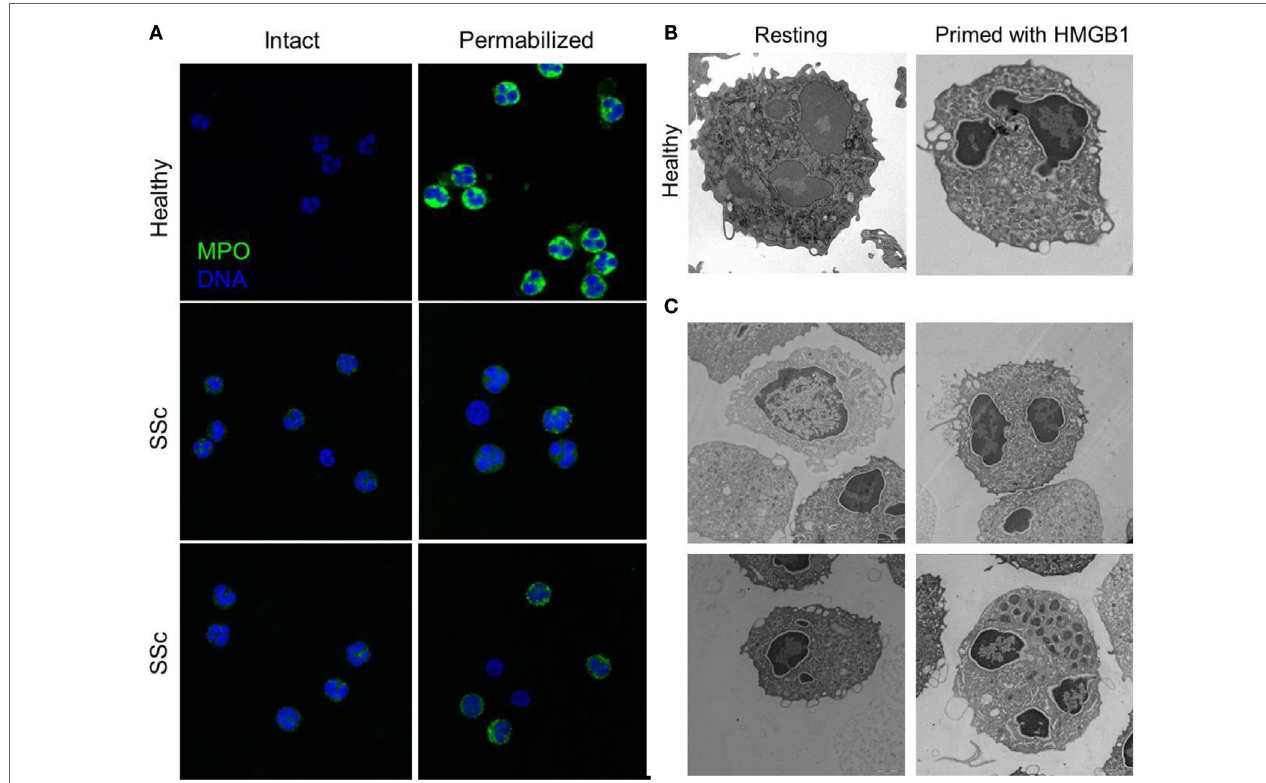
FiGURe 4 | Peripheral granules distribution characterized neutrophils of patients with SSc . (A) The expression of MPO (green) in the blood neutrophils of patients with SSc and of matched controls has been analyzed by confocal microscopy before and after permeabilization of the plasma membrane, to allow the access of the mAb. MPO intracellular expression is substantially lower in SSc patients and appears to cluster at the plasma membrane of intact, non permeabilized neutrophils. (B,C) Representative images by electron microscopy of neutrophils from a healthy control, untreated or treated with HMGB1 (B) or of untreated neutrophils from four SSc patients (C) showing the extensive remodeling of intracellular granules, most of which acquire a pericellular distribution, characterizes SSc neutrophils and healthy neutrophils treated with HMGB1. Images originally published by Maugeri et al.